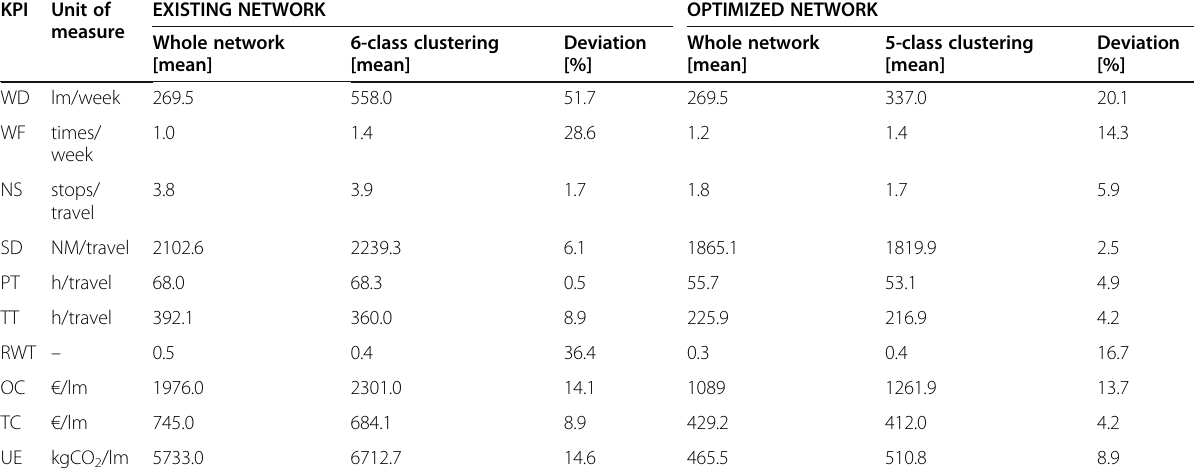
Table 18 Average deviations (whole network – clustering) in absolute value KPI Unit of